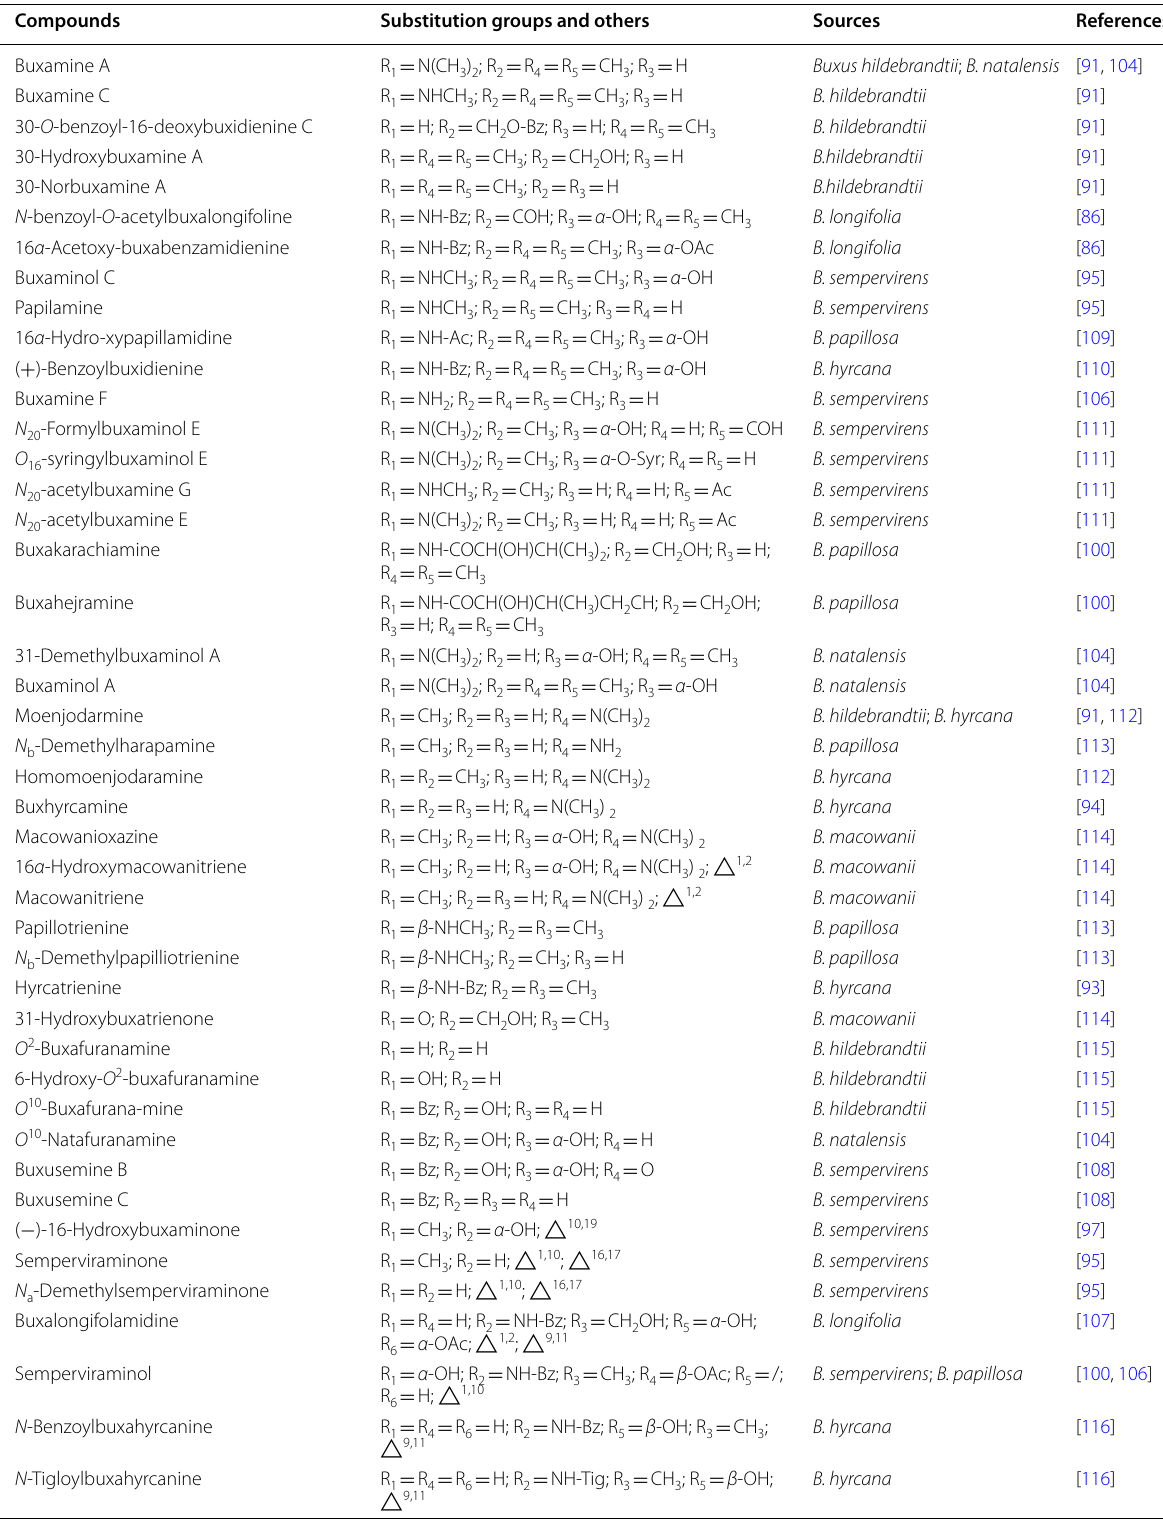
19)abeo‑14α‑methylpregnane type steroidal alkaloids 228–293 →